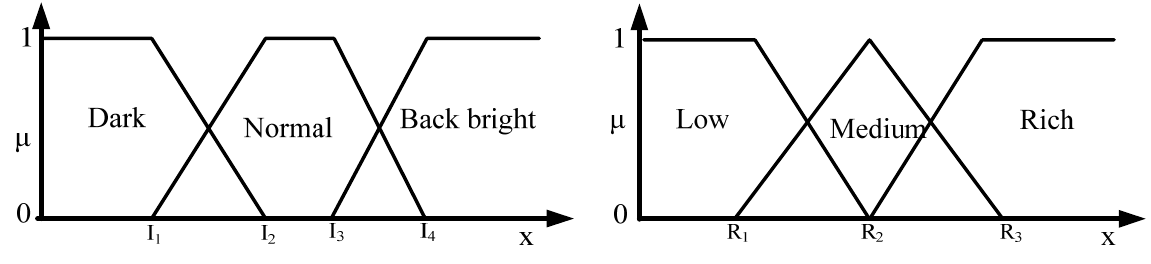
Figure 3. The nine testing images for fuzzy checking area detection.